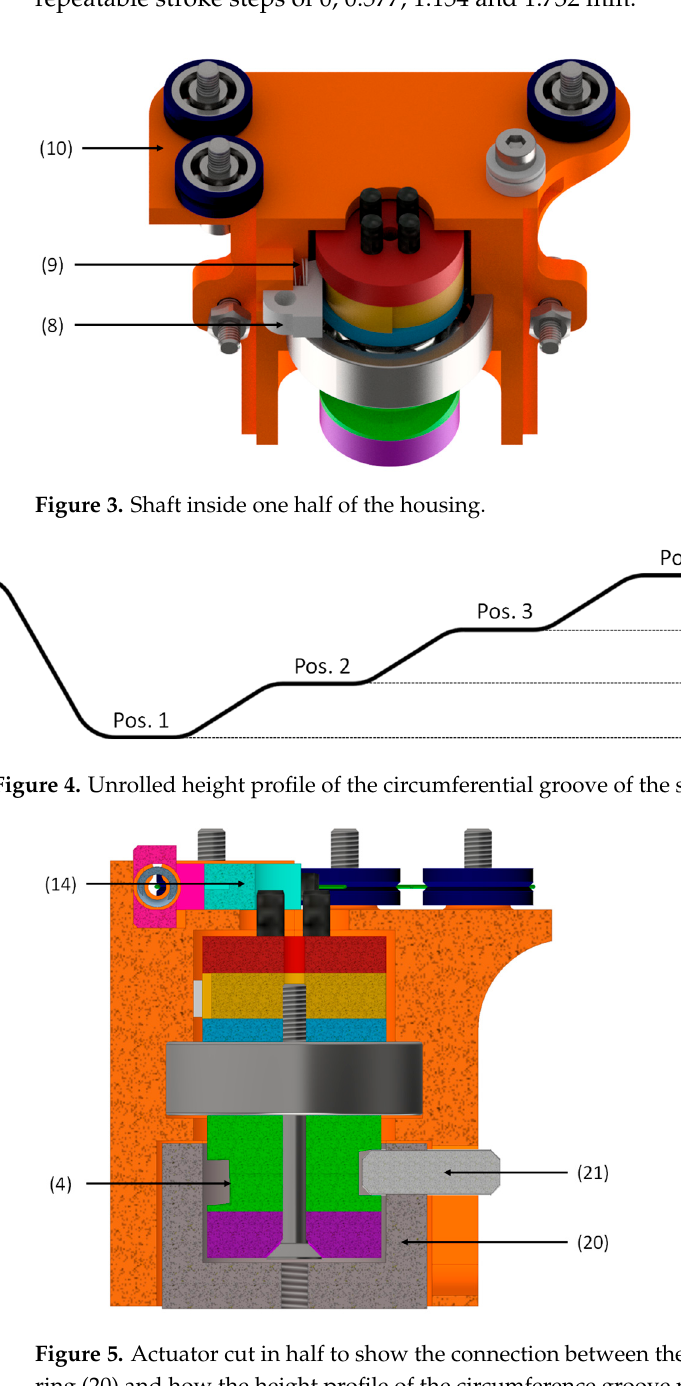
Figure 5. Actuator cut in half to show the connection between the groove (4), interface pin (21) and ring (20) and how the height profile of the circumference groove moves the ring up and down for a translational movement.